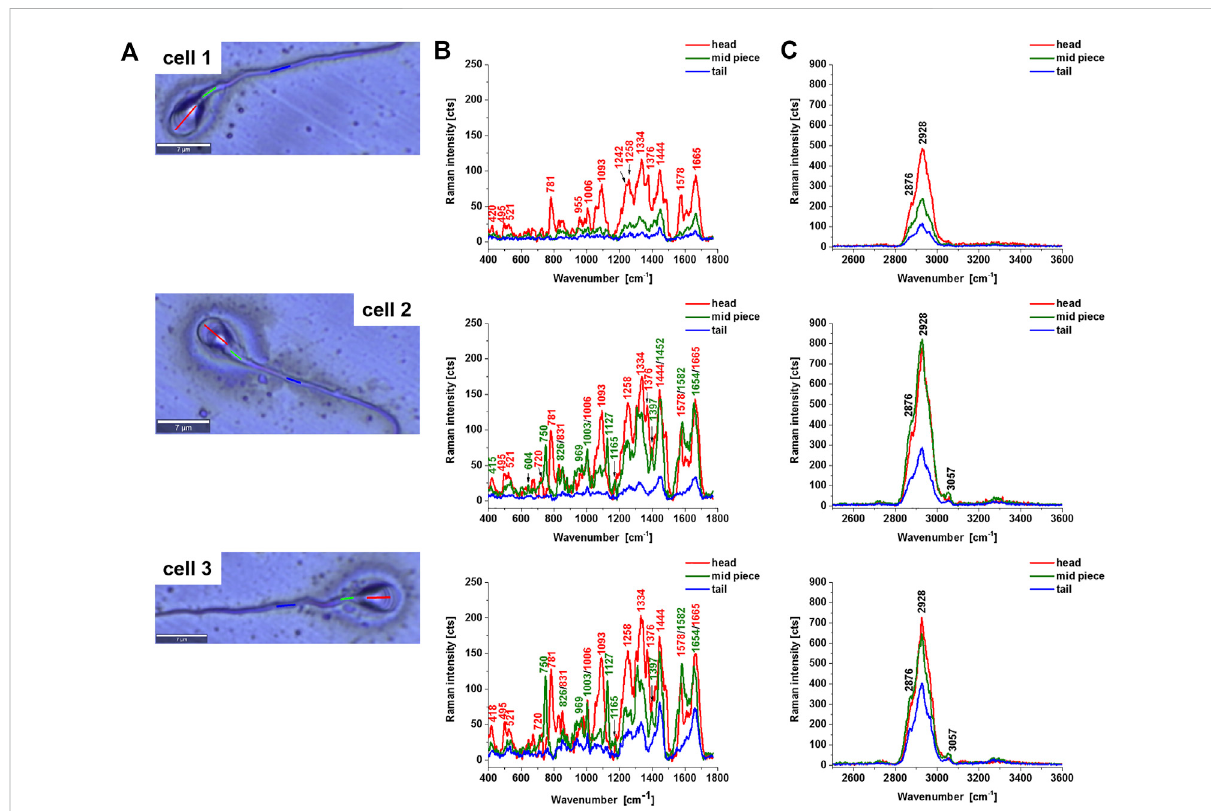
FIGURE 2 Microscope images of a human typical sperm cells (A) , the average Raman spectra of a typical sperm cell regions: head (red), midpiece (green), axsoneme and membrane cell (blue), in the fi ngerprint region (B) and high-frequency region (C) . Experimental condition: excitation 532 nm, laser power 10 mW, integration time 0.5 s, number of Raman spectra of each line n =